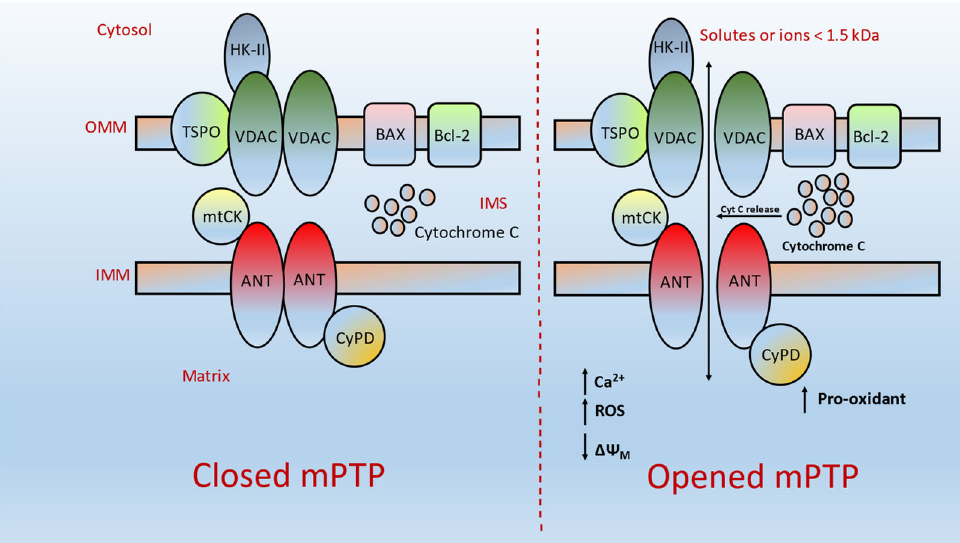
Figure 1. Schematic representation of the junction of mPTP at both opened and closed states. OMM, outer mitochondrial membrane; IMM, inner mitochondrial membrane; VDAC, voltage-dependent anion channel (mitochondrial porin); HK-II, hexokinase II; TSPO, translocator protein; ANT, adenine nucleotide transporter; CypD, cyclophilin D; Bcl-2, antiapoptotic protein; BAX, proapoptotic protein. Numerous stimuli such as pro-oxidant, enhanced intracellular Ca 2+ levels, and overproduction of ROS are able to allow the free exchange of solutes and proteins smaller than 1.5 kDa between the mitochondrial matrix and the extra mitochondrial cytosol, ultimately causing mPTP opening.